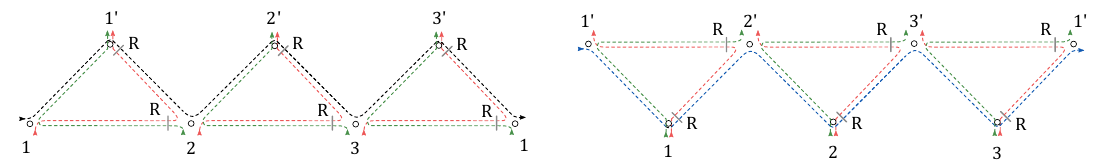
Figure 16 . Left: integral kernel t + ( x 1 , x 2 , x 3 | x 0 black dashed segments transform in the ‘ t − ( x 1 , x 2 , x 3 | x 0